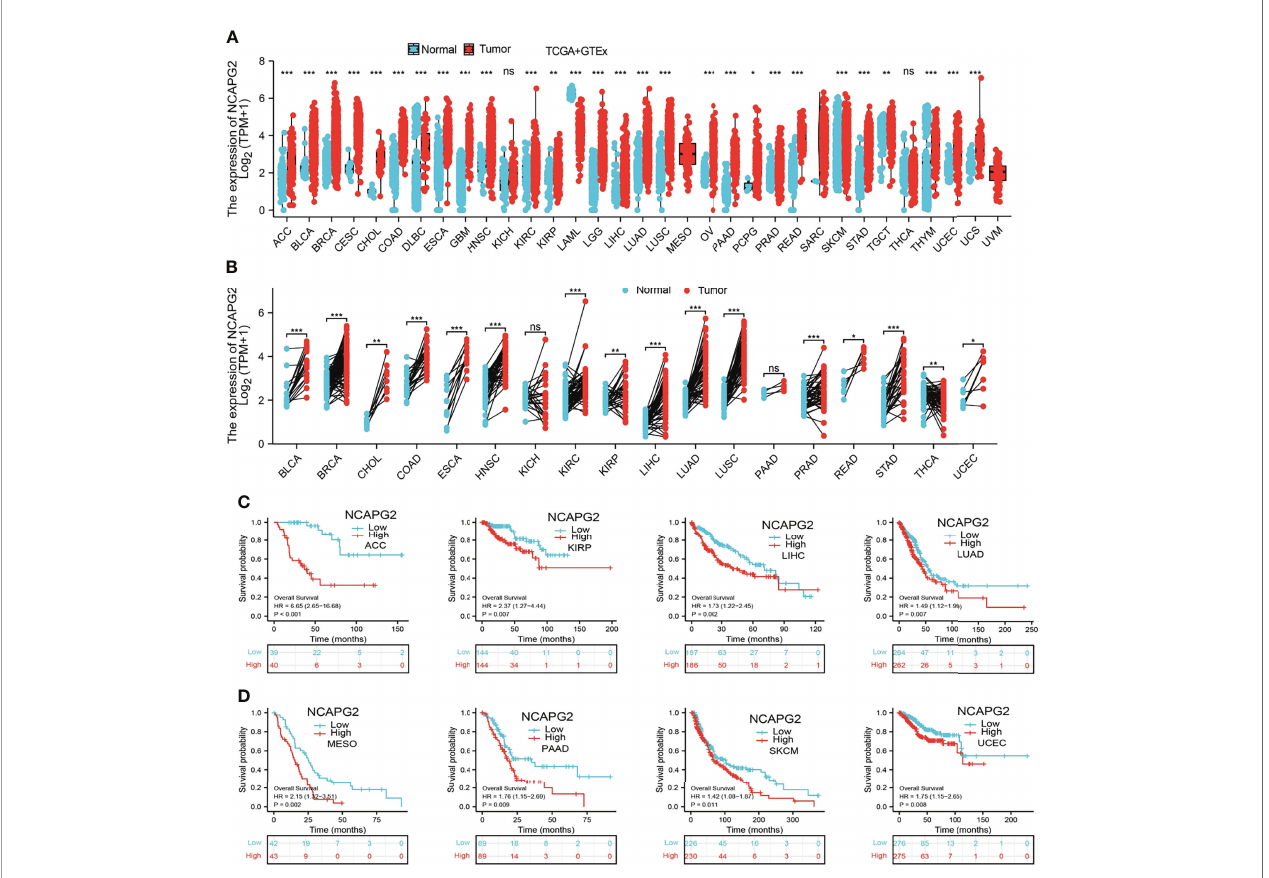
FIGURE 1 | Expression pattern and prognostic value of NCAPG2 from the perspective of pan-cancer. (A, B) NCAPG2 expression levels in different tumor tissues and adjacent normal tissues from TCGA and GTEx databases. (C, D) Prognostic analysis of NCAPG2 mRNA expression levels in various human cancers. NS, p > 0.05, * p <0.05, ** p <0.01, *** p